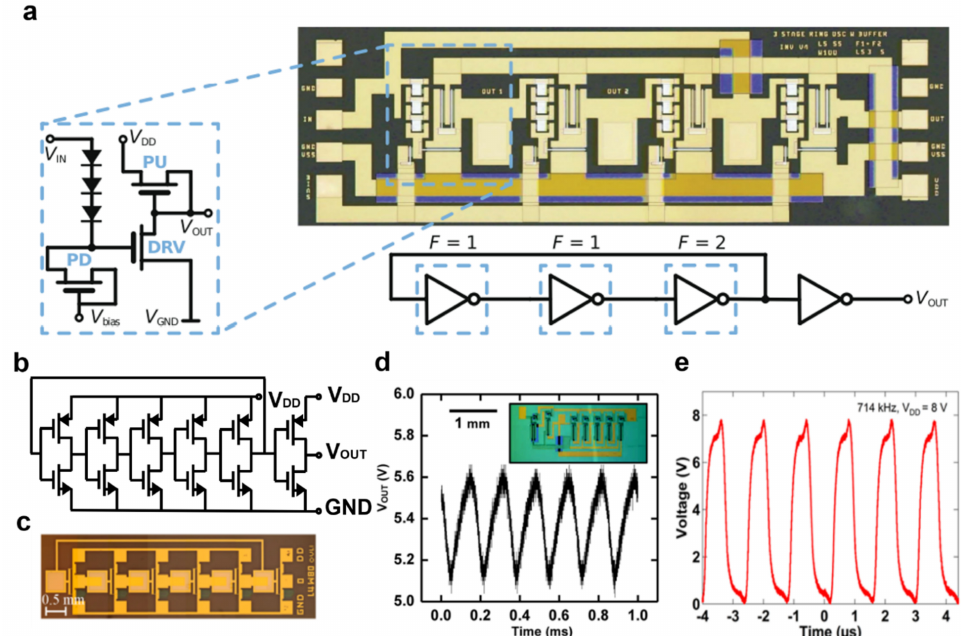
Figure 6. ( a ) Schematic diagram and microscopic image of a three-stage ring oscillator (adapted from [97] with permission from John Wiley and Sons); ( b ) Schematic diagrams of a five-stage ring oscillator; ( c ) Microscopic image of a five-stage ring oscillator; ( d ) Ring oscillation characteristics. The oscillation frequency was 5.67 kHz at VDD = 19 V (adapted from [98] with permission from American Chemical Society); ( e ) Ring oscillation characteristics. The oscillation frequency was 714 kHz at VDD = 8 V (adapted from [99] with permission from American Chemical